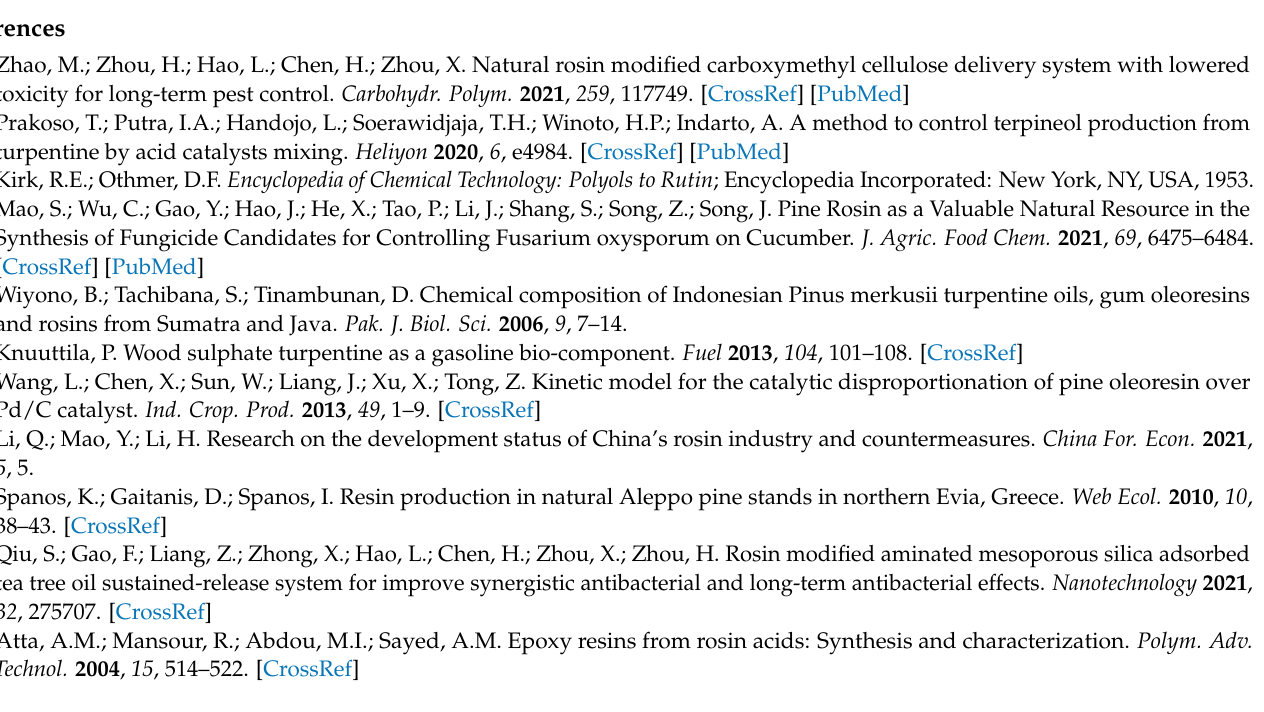
Table S3: Values of volume parameter (r) and surface parameter (q) for dehydroabietic acid and selected